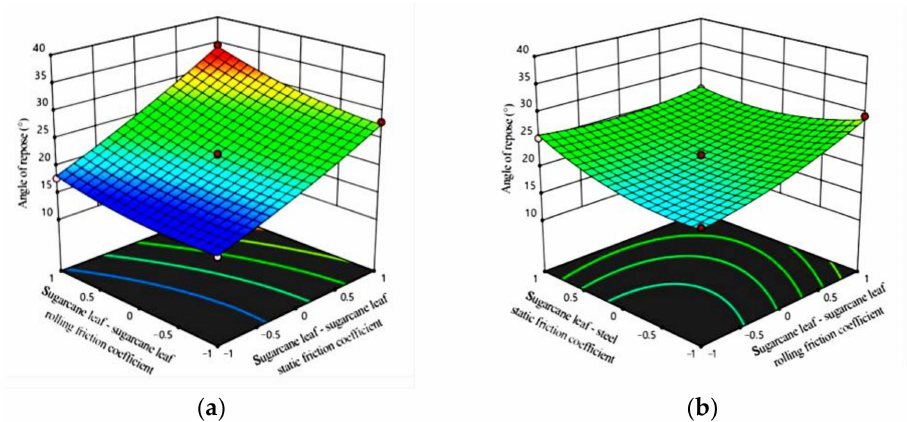
Figure 12. Effect of interaction on the angle of repose: ( a ) interactive effects of sugarcane leaf- sugarcane leaf static friction coefficient and sugarcane leaf-sugarcane leaf rolling friction coefficient, ( b ) interactive effects of sugarcane leaf-sugarcane leaf rolling friction coefficient and sugarcane leaf-steel static friction